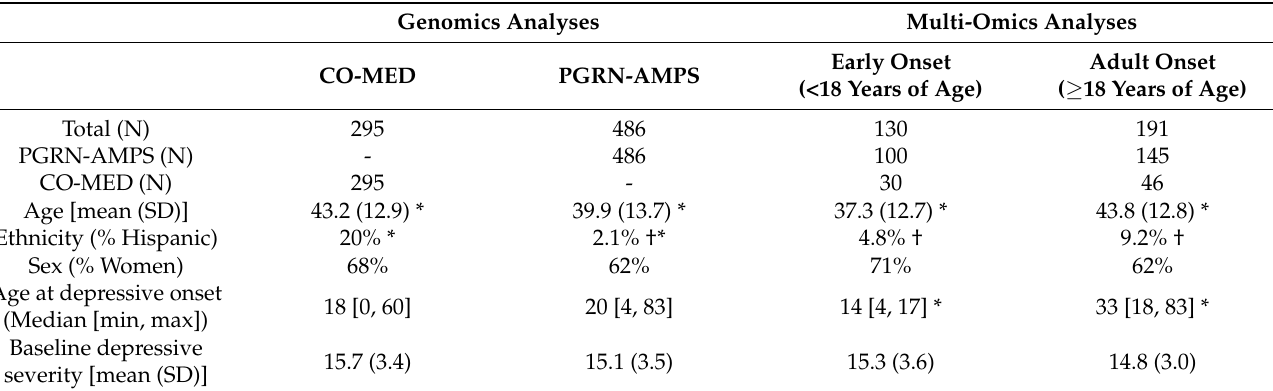
Table 1. Demographics and patient